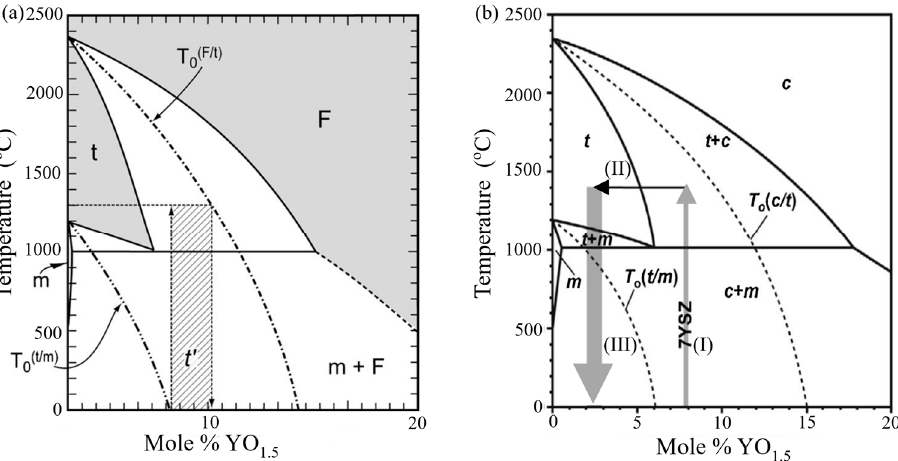
Figure 1. ( a ) ZrO 2 –Y 2 O 3 phase diagram showing non-transformable tetragonal (t’) in the hashed area; ( b ) ZrO 2 –Y 2 O 3 phase diagram under CMAS infiltration. The arrow denotes the interaction with CMAS. Reprinted with permission from [1] 2008 Elsevier.